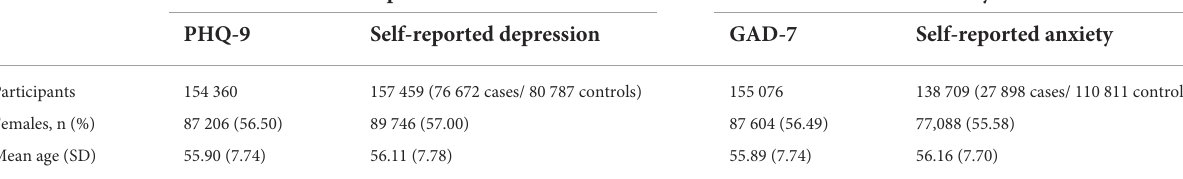
TABLE 1 The basic characteristics of study